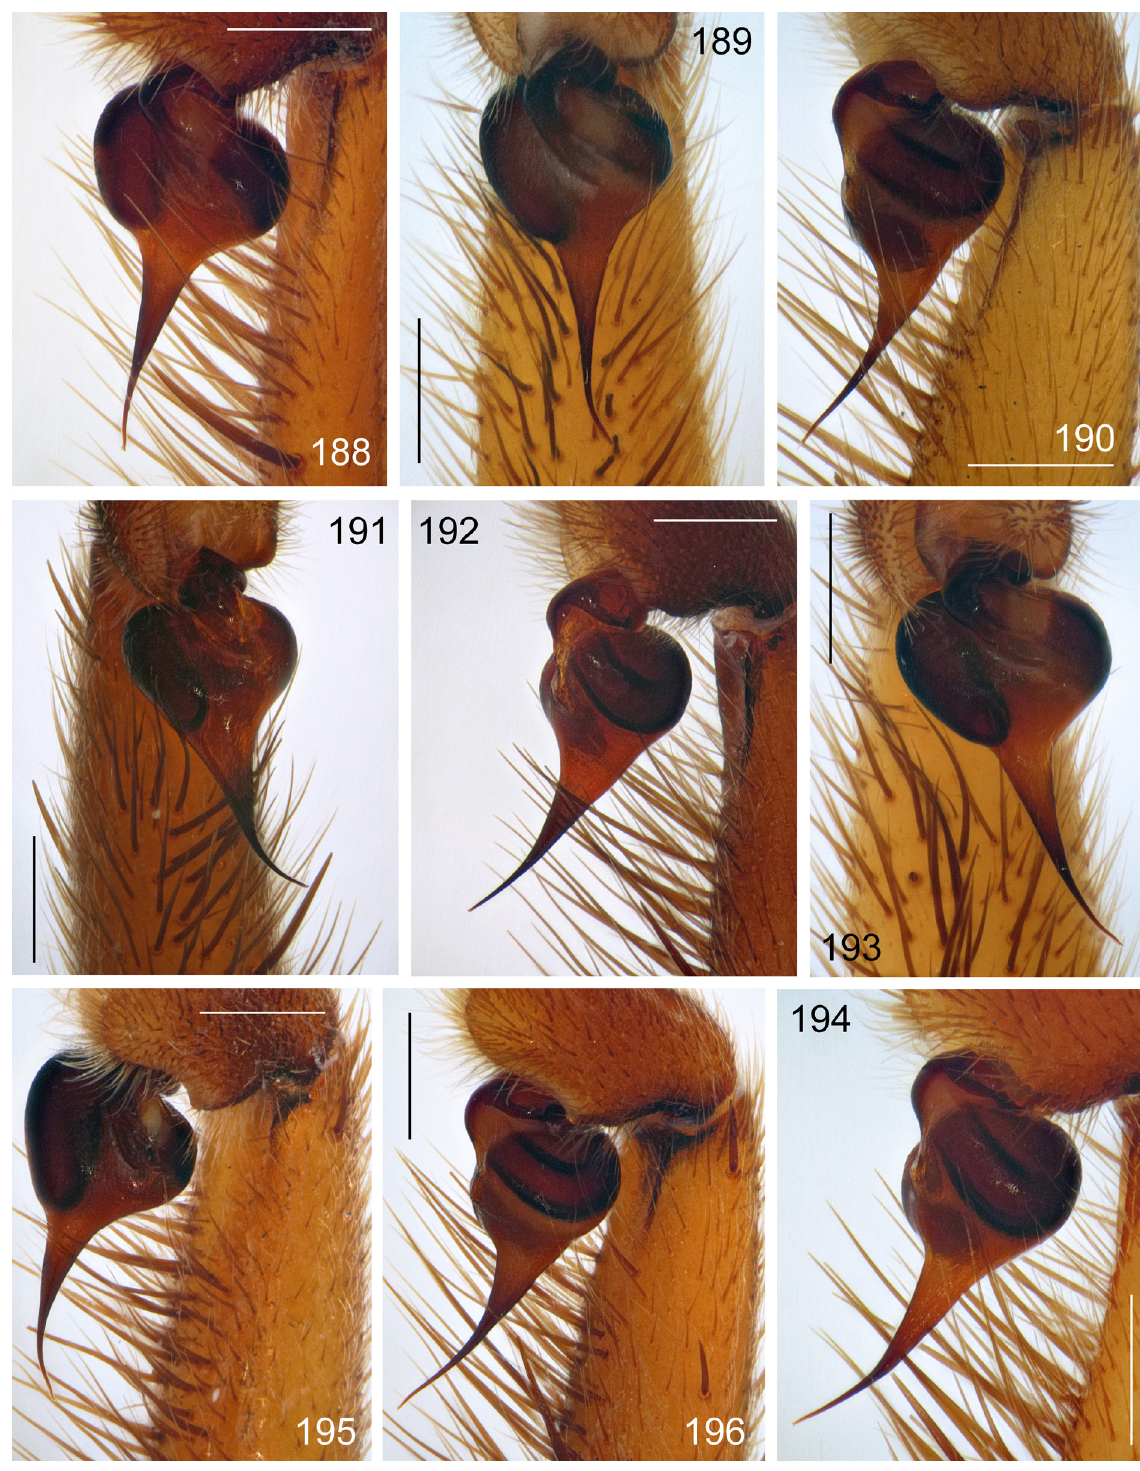
Figs 188–196. Anemesia spp., ♂♂, details of palpal organ; ventral (188–189, 191, 193–194) and retrolateral (191, 192, 195–196) views. 188–190 . A. birulai (Spassky, 1937) (holotype and conspecific ♂ from Zulfagar Mts, respectively). 191–192 . A. koponeni Marusik, Zamani & Mirshamsi, 2014 (holotype). 193–194 . A. pococki sp. nov. (holotype). 195–196 . A. tubifex (Pocock, 1889) (Kalaimor). Scale bars: 0.5